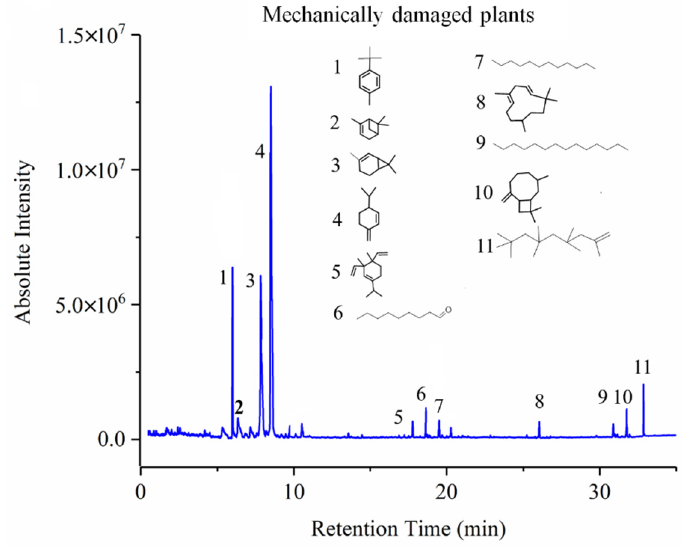
Figure 10. GC-MS spectrum of mechanically damaged plant.